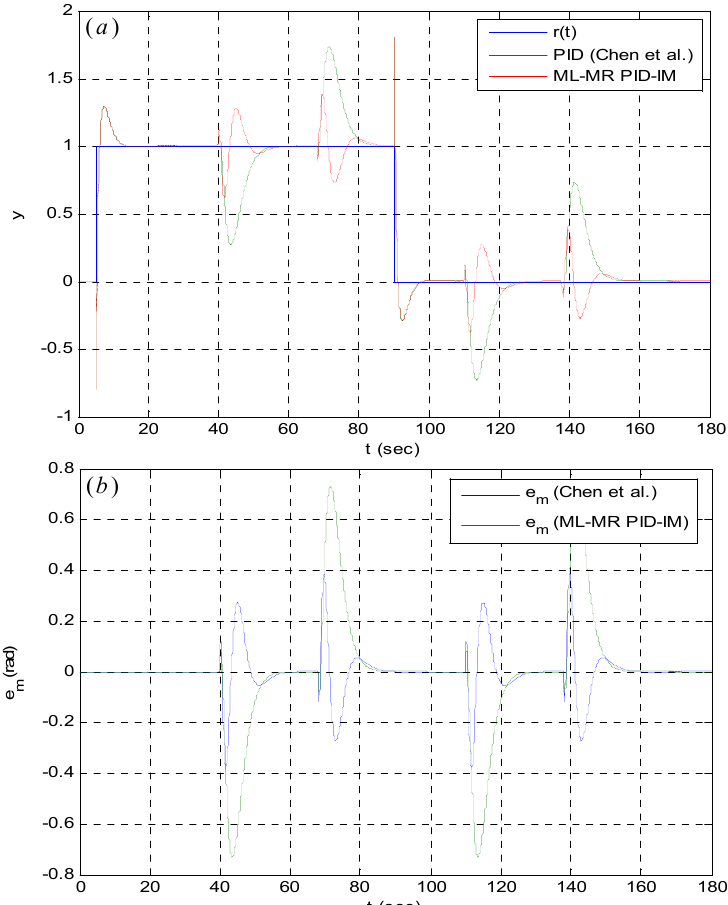
Figure 14. Improvement of the disturbance rejection performance of the classical optimal PID loop by the proposed ML-MR PID-IM control structure for liquid level control in the reboiler model. ( a ) Step response and ( b ) change of model error